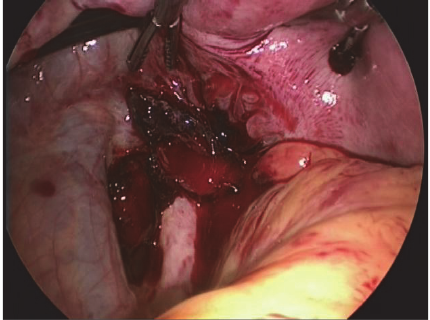
Figure 1: Diagnostic laparoscopy: blood identification in the right hypochondrium (liver).